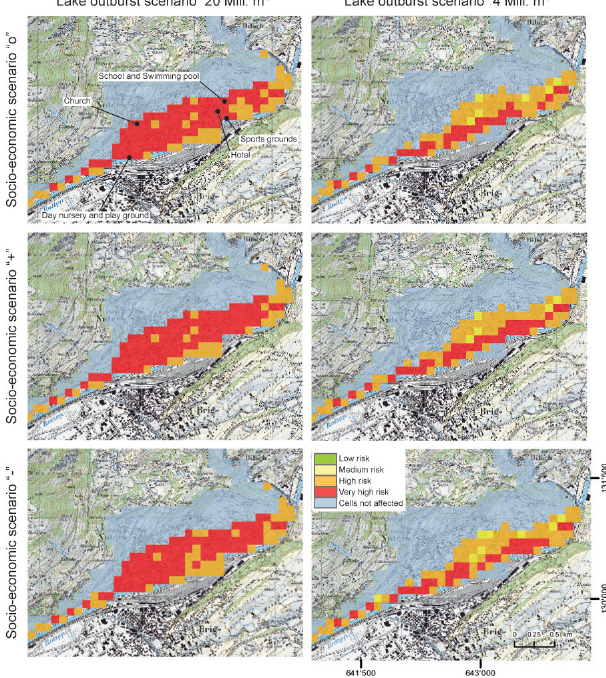
Figure 7. Risk for Naters in 2045 for lake outbursts considering the risk matrix (a) in Fig. 4. The three rows indicate the socio-economic scenarios “o”, “ + ” and “ − ”, the two columns the lake outburst sce- narios with 20 and 4millionm 3 . Arrows indicate hotspot locations of social vulnerability. Reproduced with permission of Swisstopo (BA110005) and BFS (1986,